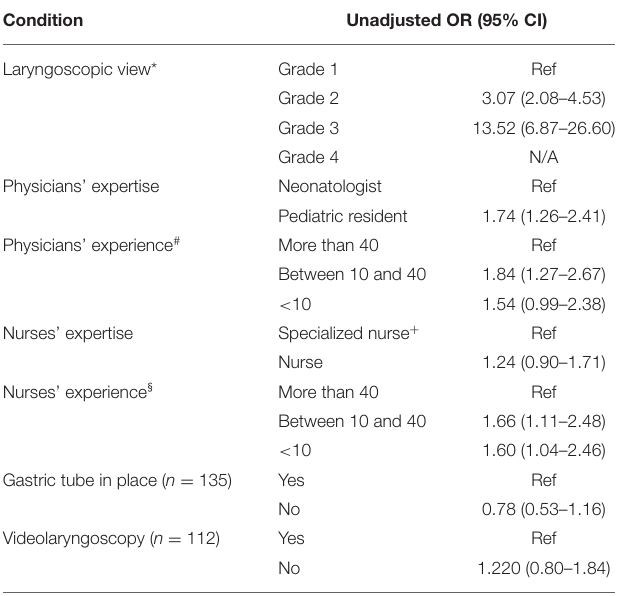
TABLE 4 | Factors associated with TIAEs. TABLE 5 | Factors associated with unsuccessful intubation attempts ( n = 363) vs. successful attempts ( n = 258).